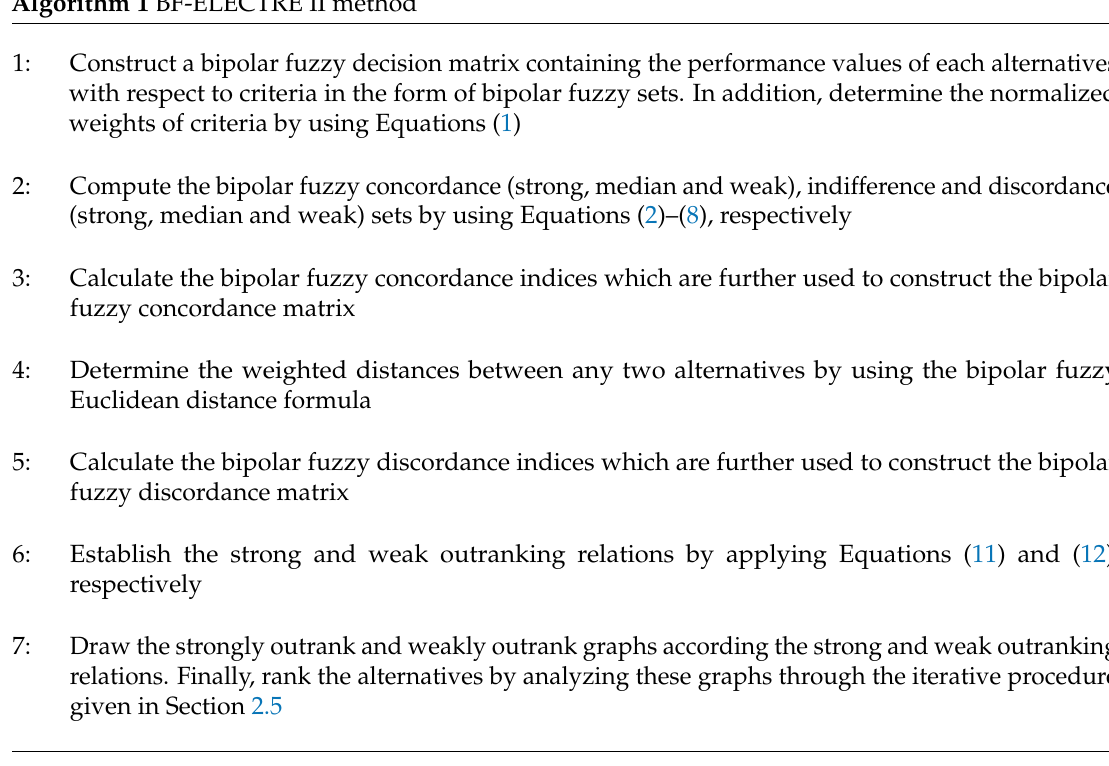
Algorithm 1 BF-ELECTRE II method